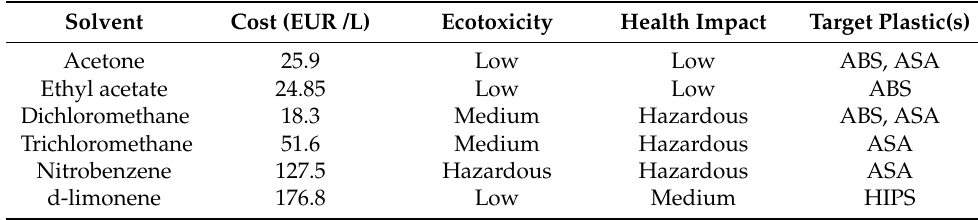
Table 4. Cost and health/environmental impact of selected solvents. The target plastics can be dissolved by the solvent on the same line, as checked in the